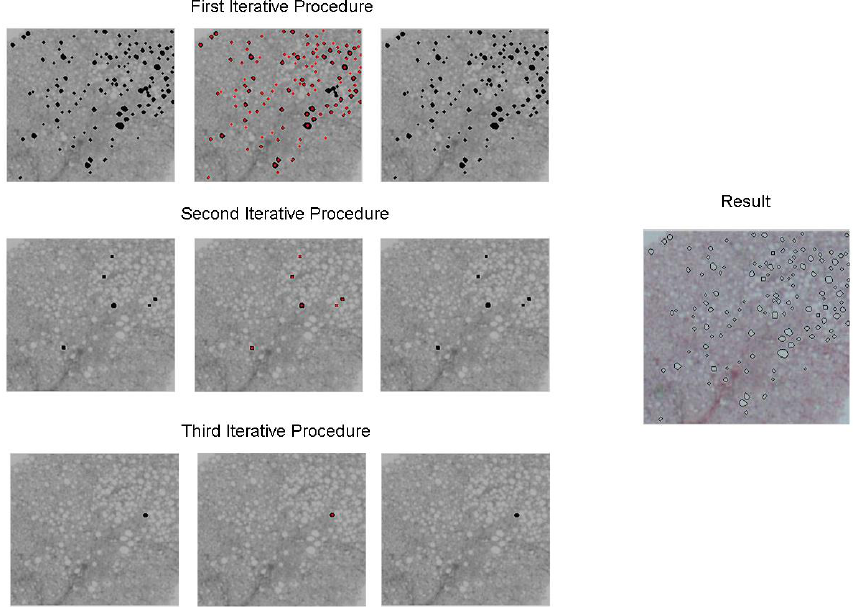
Figure 4 . Results from each iteration of the second stage: (first column) results of eccentricity; (second column) results of roundness; (third column) accepted regions; (last figure) final result.